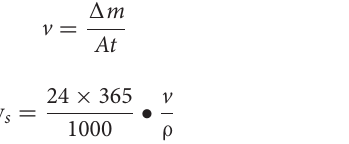
TABLE 3 | Electrochemical parameters for pure Zn and GNS/Zn composites in SBF solution.